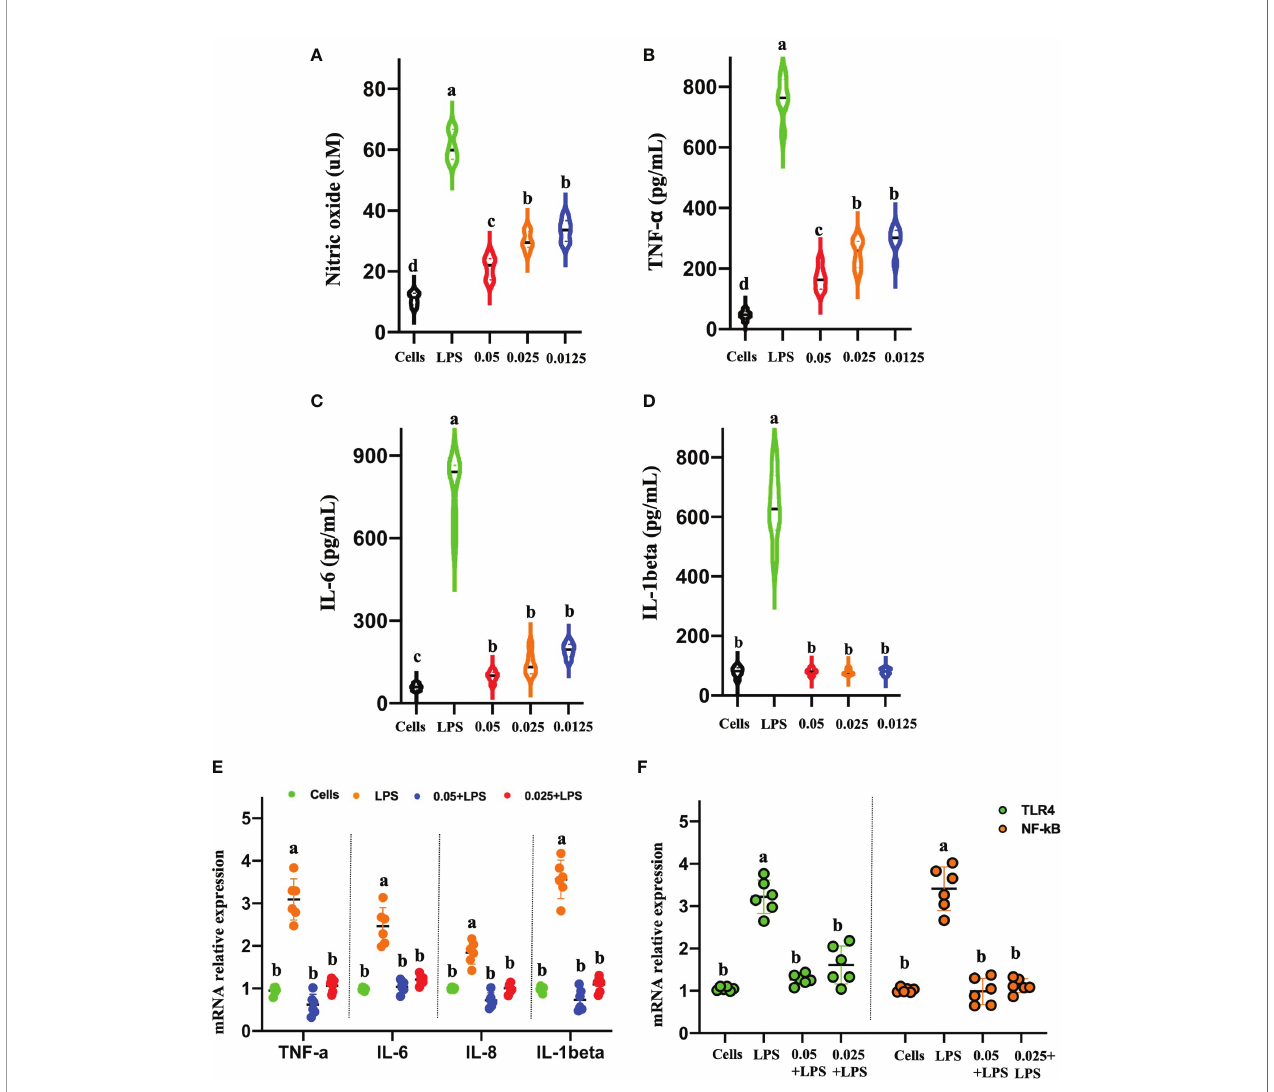
FIGURE 5 | CNMs attenuated proin fl ammatory responses in LPS-challenged RAW264.7 cells. RAW264.7 cells were treated with 1 µg/ml LPS and incubated with CNMs at different concentrations (0.0125%, 0.025%, and 0.05%). Supernatant was collected at 24 h after culture, and the contents of nitric oxide (A) and tumor necrosis factor- a (B) , interleukin (IL)-6 (C) , and IL-1 b (D) were detected by ELISA. (E, F) The proin fl ammatory cytokines mRNA expression levels of TNF- a , IL-6, IL- 1 b (E) , TLR4, and NF- k B (F) were determined by qPCR. Data are indicated as the mean ± standard error from six biological replicates. Means with different lowercase letters indicate signi fi cance ( p <